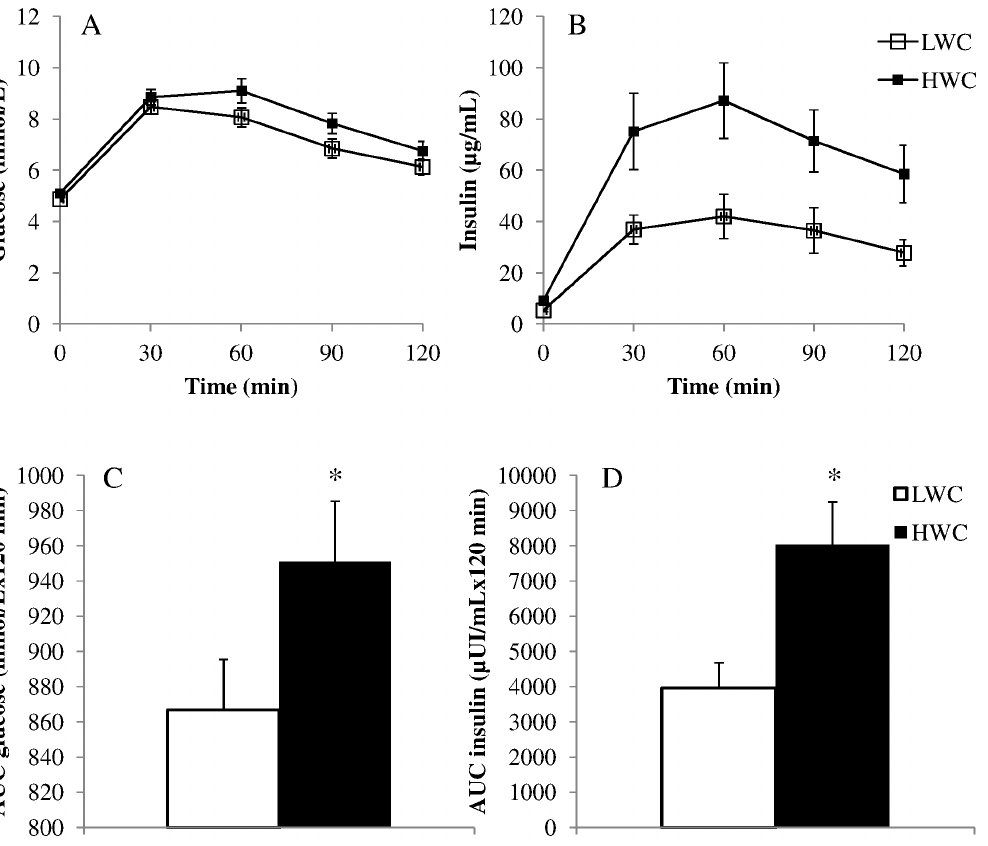
Figure 1. Oral glucose tolerance tests in men with obstructive sleep apnea and high waist circumference or low waist circumference. Plasma glucose (A) and plasma insulin (B) levels in men with obstructive sleep apnea syndrome and high waist circumference (HWC) or low waist circumference (LWC) during 120 minutes of the 75 g oral glucose tolerance test. Area under the curve (AUC) of plasma glucose (C) and plasma insulin (D) are compared between men having obstructive sleep apnea syndrome and HWC vs. LWC. *p , 0.05.